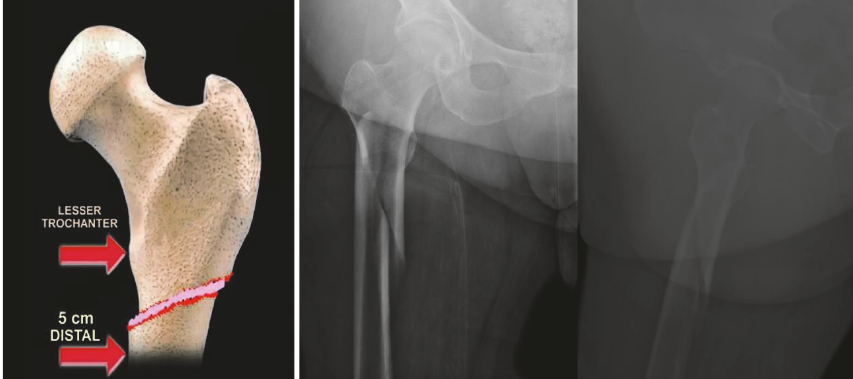
Figure 1: Anatomy of the subtrochanteric area of the femur: the subtrochanteric area of the femur is defined as the area 5 cm distal to lesser trochanter.